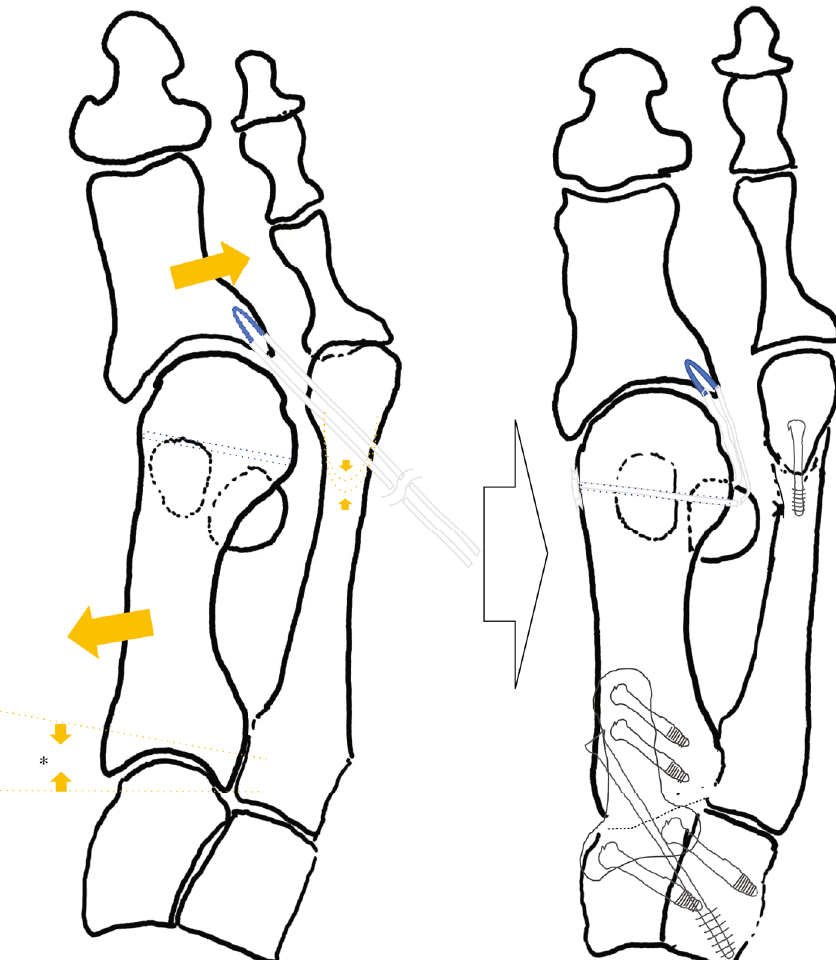
Figure 3: Schema of the surgical